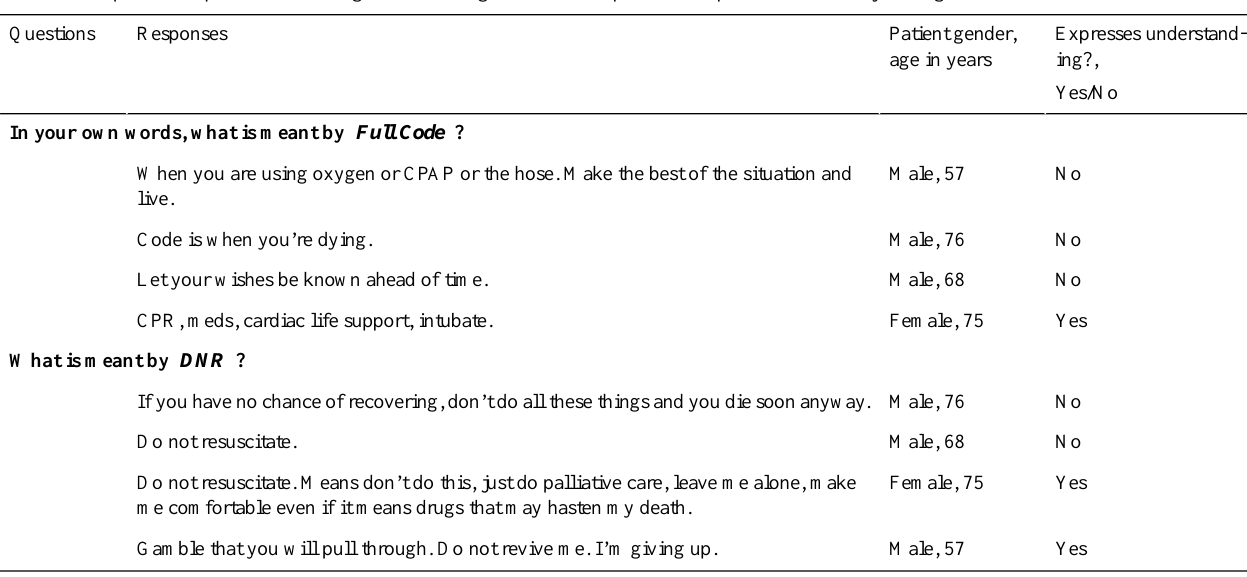
Table 3. Responses to questions assessing understanding of treatment options from phase 2 of usability